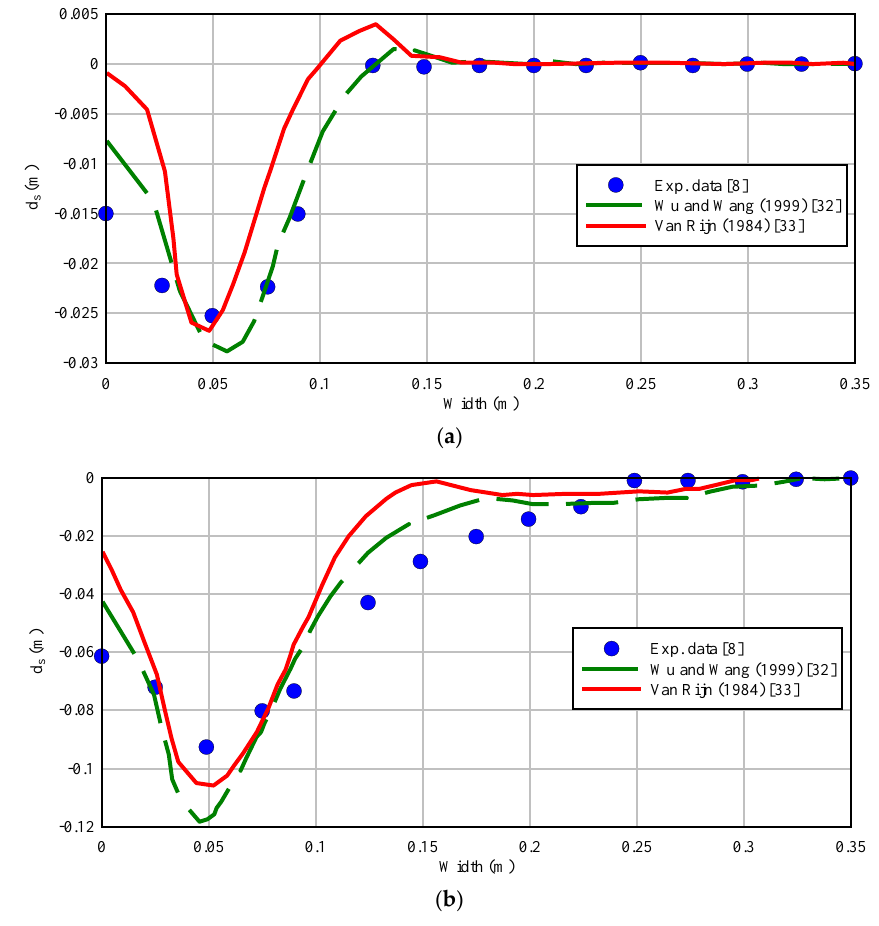
Figure 5. Comparison between experimental data and numerical simulation based on Wu and Wang (1999) [32] and Van Rijn (1984) [33]. ( a ): Junction angle θ = 75°; ( b ): Junction angle θ = 60°.